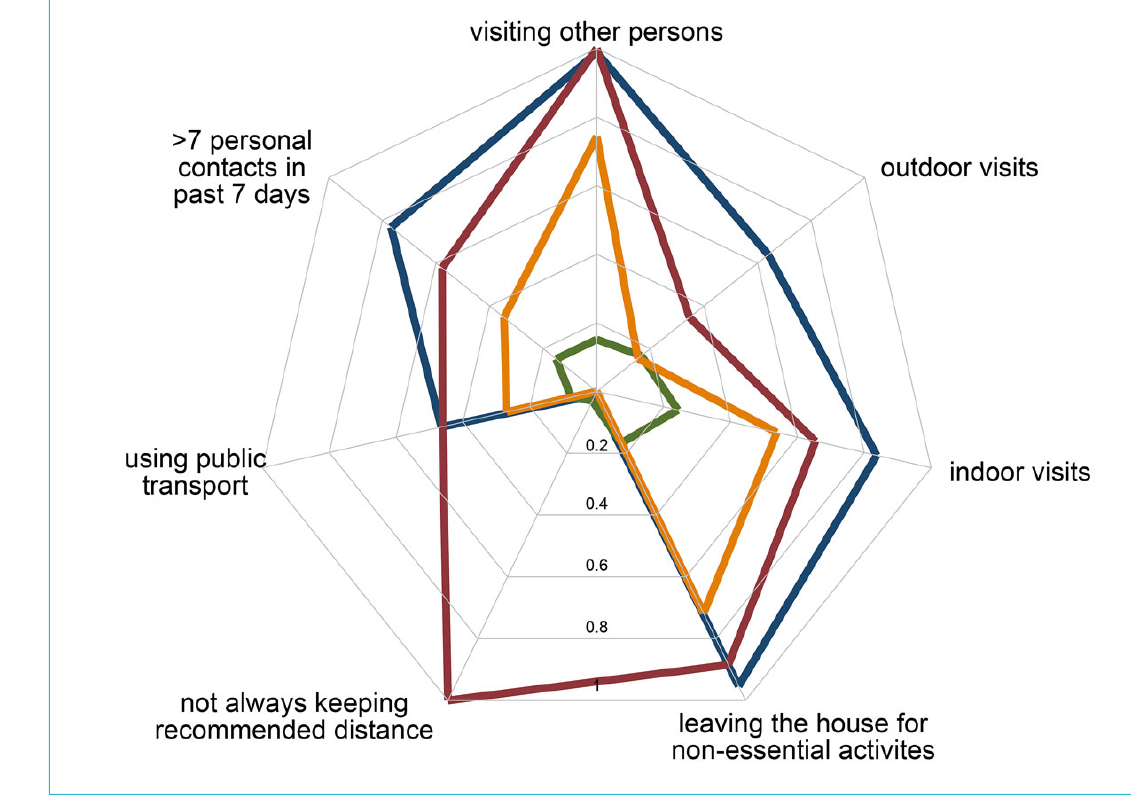
Figure 2: Radar plot visualising findings from an exploratory factor analysis on self-reported adherence to recommended preventive measures among elderly persons in Switzerland. Colours correspond to the four distinct groups presented in table 2: “good adherence to preventive measures” (blue; group 1, n = 86), “many social contacts and relatively low adherence” (red; group 2, n = 26), “few contacts and few social ac- tivities” (green; group 3, n = 66), “few contacts but more social activities” (yellow; group 4, n = 78). Lower values correspond to lower adher- ence to the specific prevention measure and, thereby, to a higher risk for an